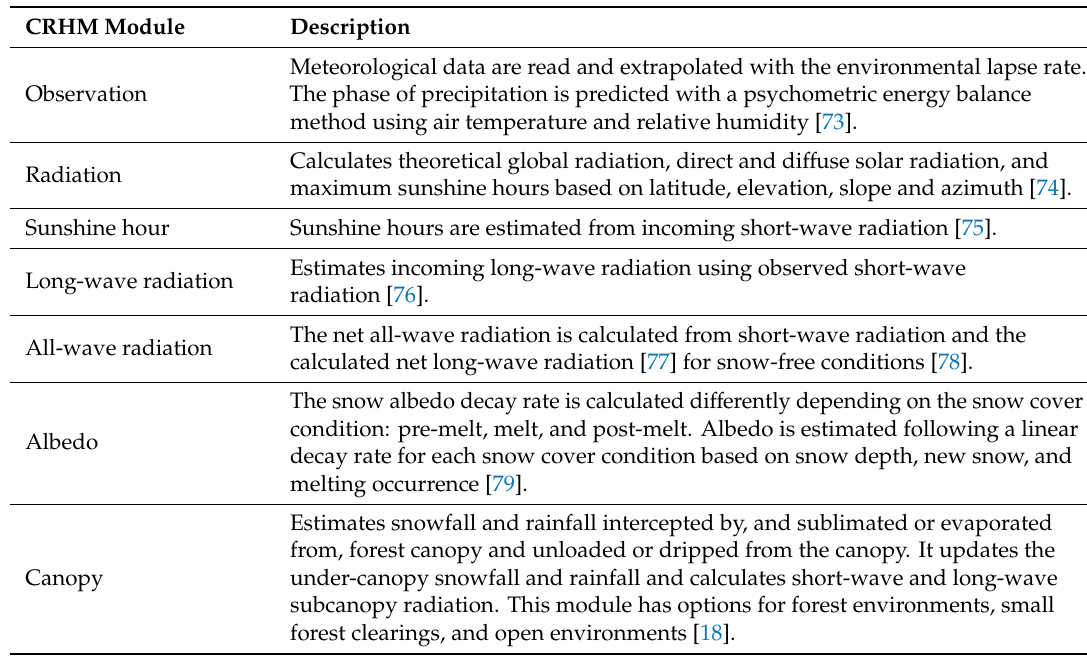
Table 1. Modules used in the Cold Regions Hydrological Modelling (CRHM) platform to simulate the hydrological processes in the Acadie River